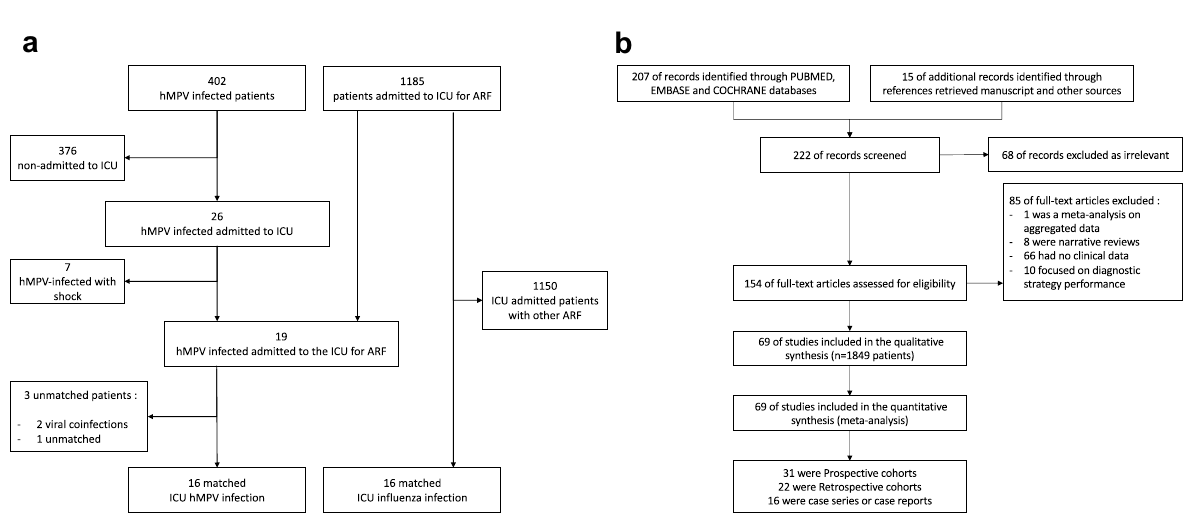
Fig. 1 Flow charts. a Flow chart of the cohort study. b Flow chart of the systematic review. ARF acute respiratory failure, ICU intensive care unit, hMPV human